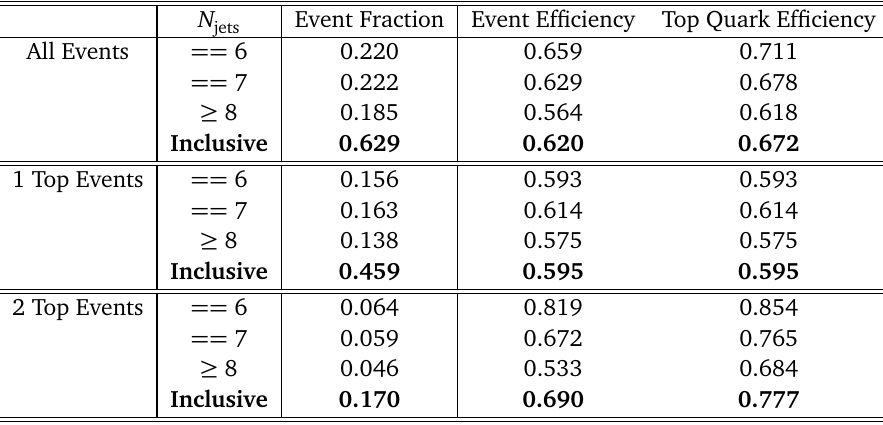
Table 8: S PA -N ET results on t ¯ t using Herwig showering.